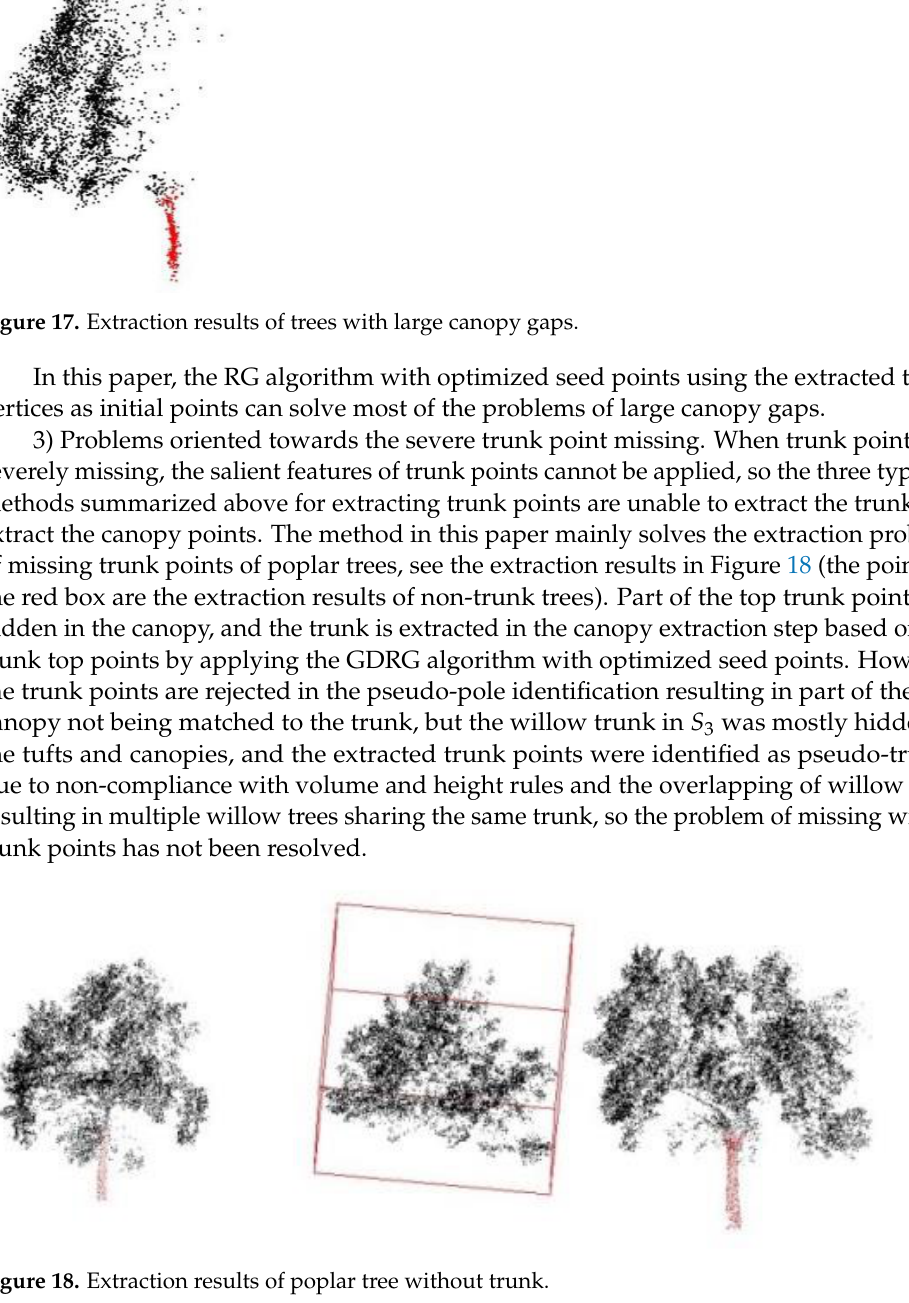
Figure 18. Extraction results of poplar tree without trunk.